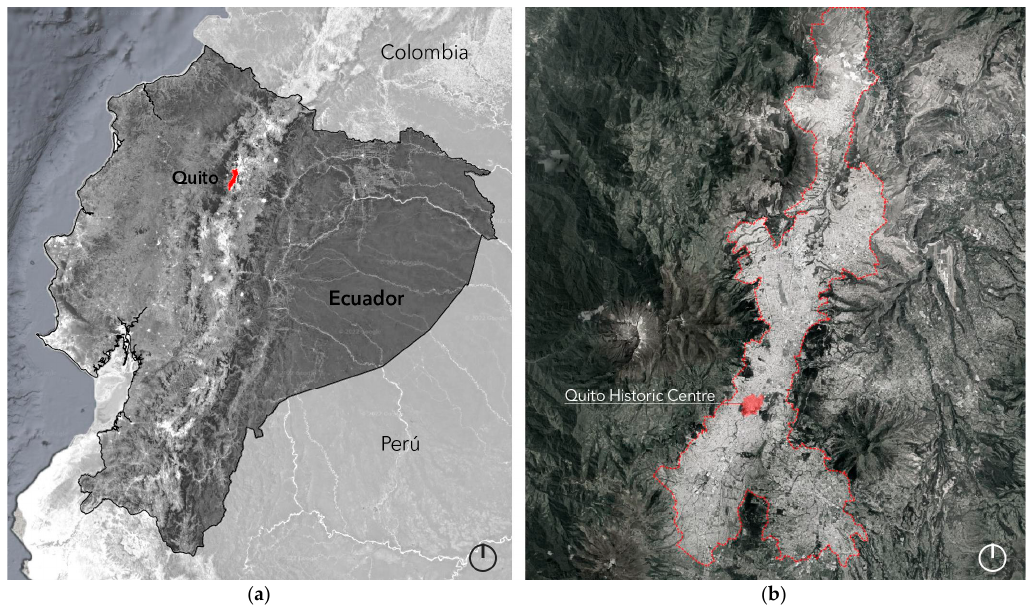
Figure 1. ( a ) Site map of Ecuador. Scale: 1:8,000,000; ( b ) Site map of Quito. Scale: 1:500,000.